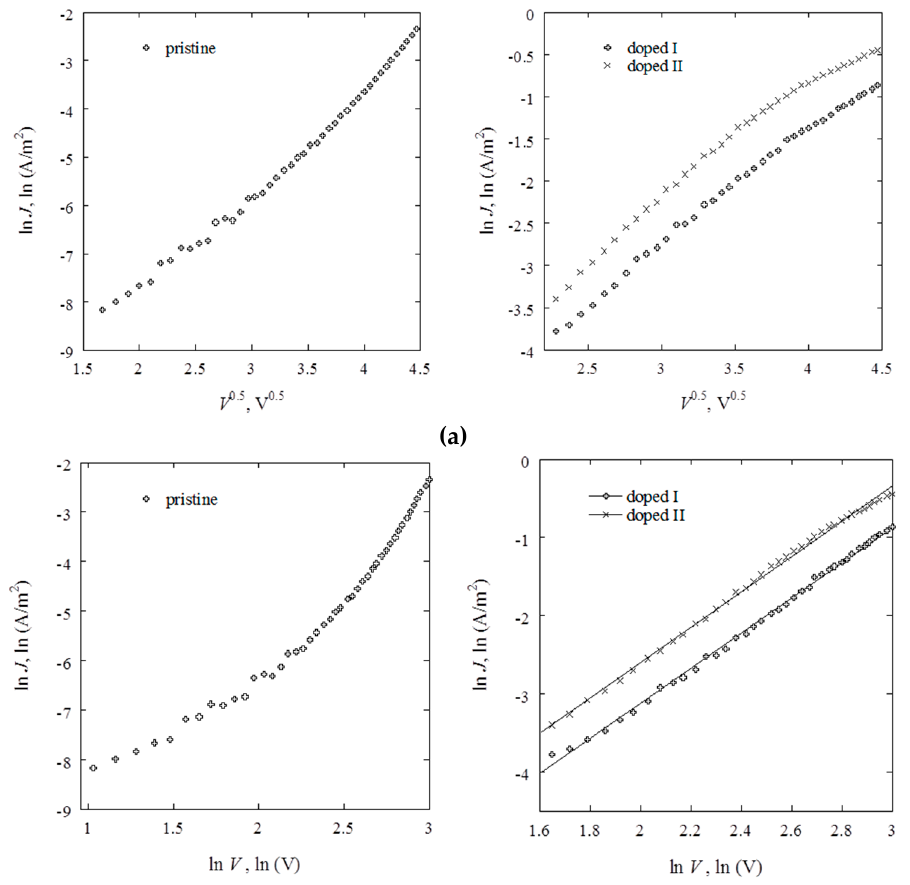
Figure 5. ( a ) Schottky/Poole–Frenkel and ( b ) space charge limited conduction mechanism fits to J–V curves in the high-field region for pristine and iodine-doped polyterpenol.